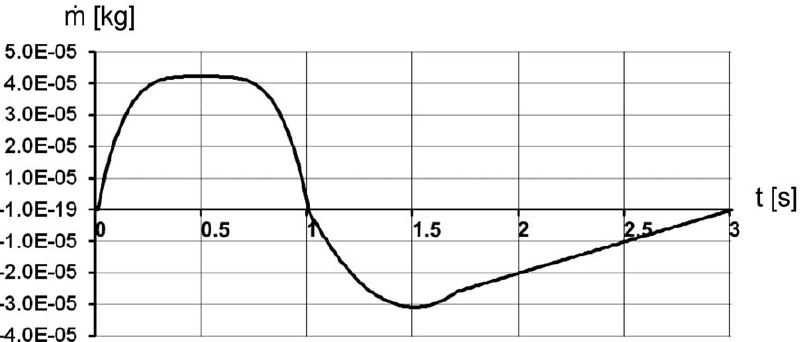
Figure 4. Mass flow through the orifice during one breathing cycle. 1 s corresponds to end-inspiration.